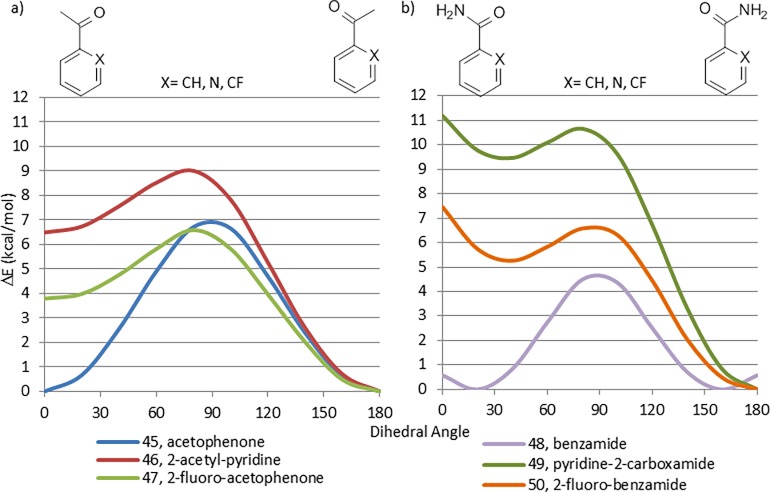
a) Comparison between CEPs of aryl acetyls, b) Comparison between CEPs of aryl primary amides.